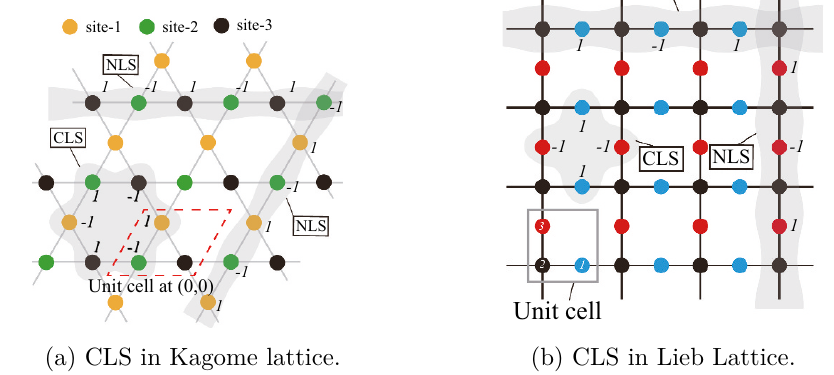
Figure 1. (a) A compact localized state (CLS) and two non-contractible loop states (NLSs) of the nearest neighbor tight-binding model on the kagome lattice. The red dashed box represents the unit cell located at R 0 ; 0 . (b) The bilayer square lattice. Hopping parameters corresponding to à Ö Ü the black and green dashed arrows are 1 = 2, and those for the red arrows are 2. (c) A compact localized state and two non-contractible loop states of the Lieb lattice model with only the nearest neighbor hopping processes. Band structures for the models in (a), (b), and (c) are represented in the lower panels (d), (e), and (f), respectively. All the figures are adapted from [81].